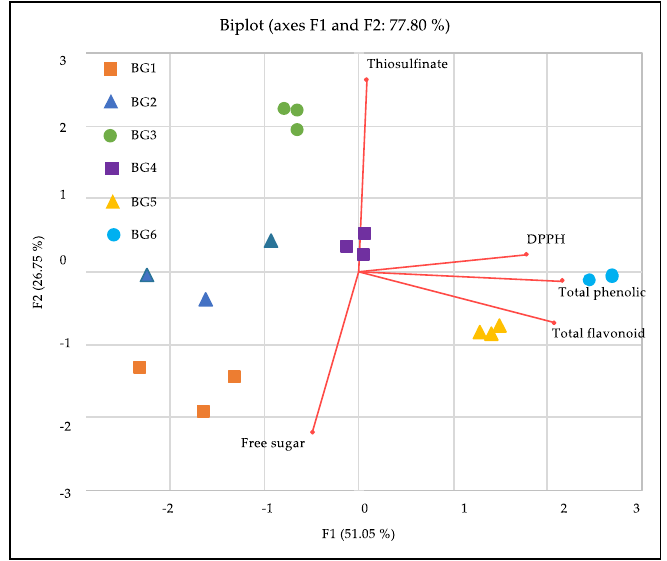
Figure 5. The PCA analysis with chemical compositions BG1, BG2, BG3, BG4, BG5 and BG6 were processed from raw material with different iMC (BG1, BG2, BG3, BG4, BG5 and BG6 with 72.60%, 66.78%, 59.99%, 56.44% 51.15% and 49.95%, respectively).